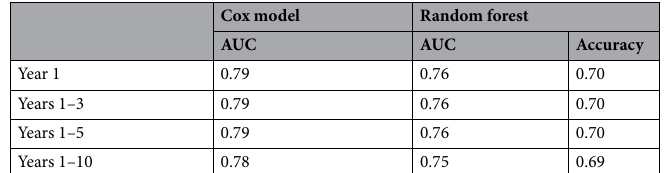
Table 4. Performance of the Cox model and the random forest classification model. Cox model adjusted for age, sex, modified CCI, hypertension, diabetes, hyperlipidemia, temperature, relative humidity, PM 2.5 , NO 2 , and SO 2 in the corresponding year. Random forest classification: age, sex, modified CCI, hypertension, diabetes, hyperlipidemia, temperature, relative humidity, PM 2.5 , CO, SO 2 , NO, NO 2 , NO x , and O 3.